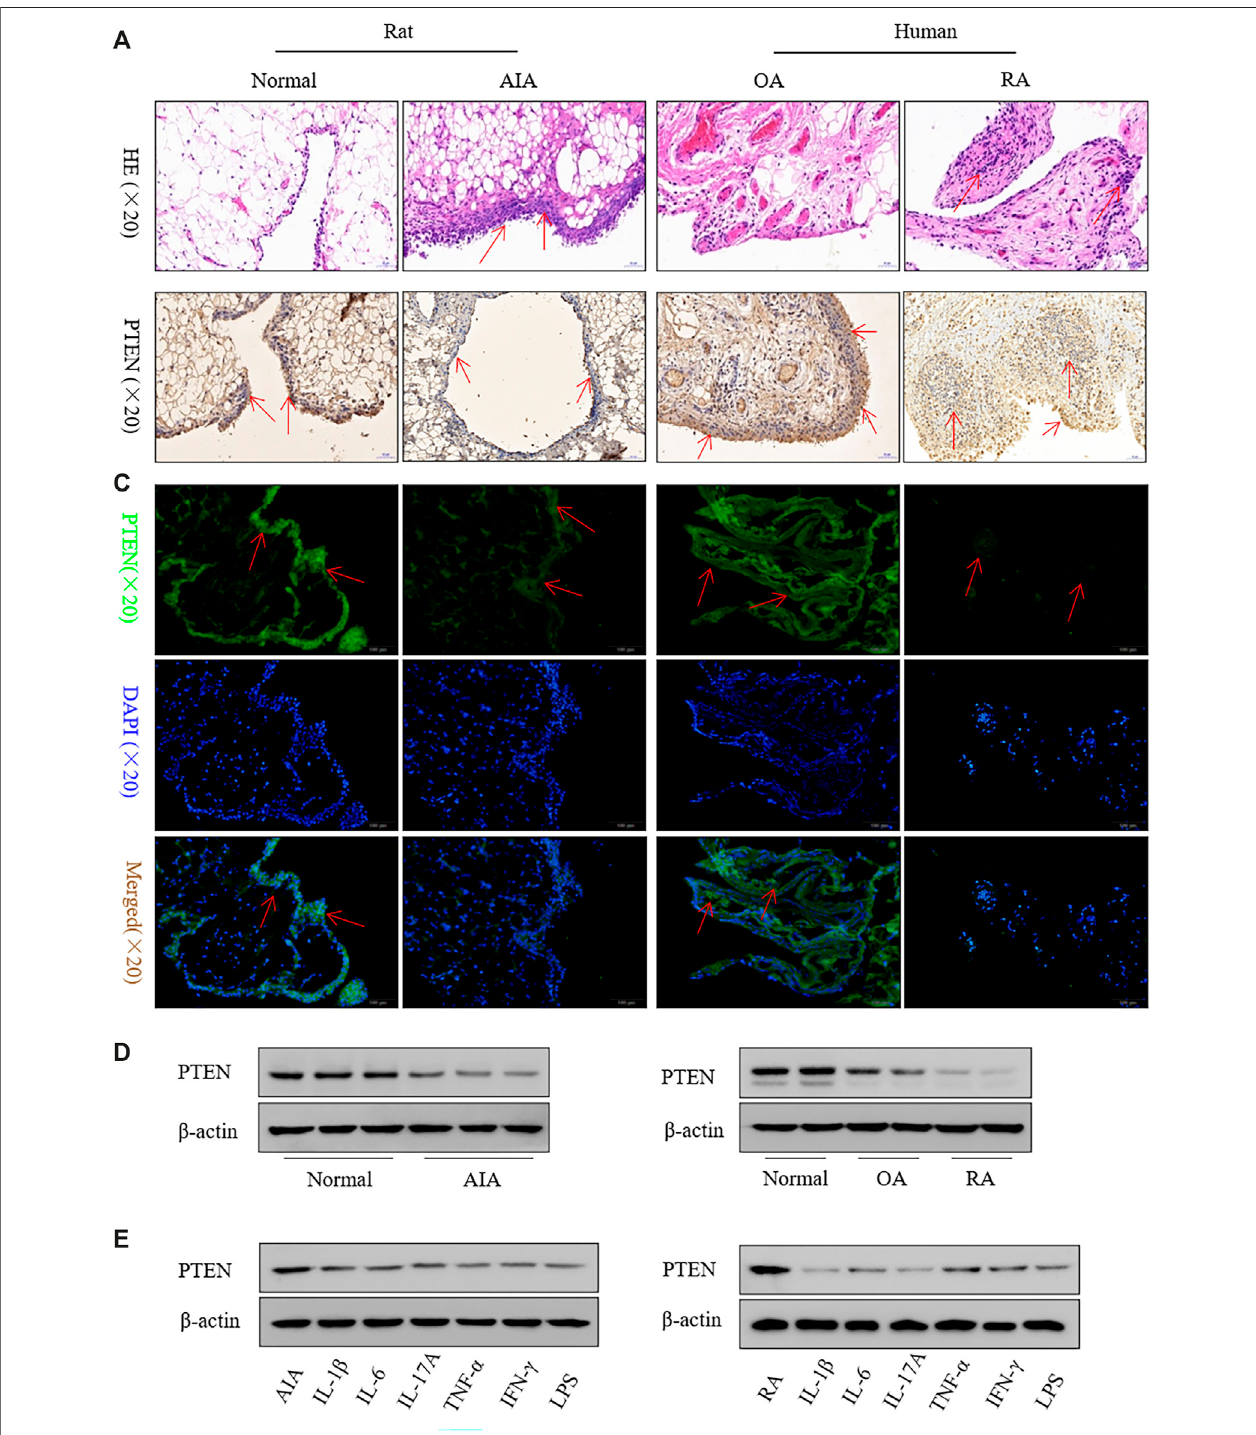
FIGURE 1 | PTEN expression is reduced in FLS from clinical RA specimens and a rat model of AIA. (A) Representative images of hematoxylin and eosin staining in synovium. (B, C) Representative images of PTEN immunoreactivity in synovium detected by immunohistochemistry (B) and immuno fl uorescence labeling (C) . (D) Western blot analysis of PTEN protein levels. (E) and after treatment with IL-1 β (2 ng/ml), IL-6 (5 ng/ml), IL-17A (10 ng/ml), TNF- α (10 ng/ml), IFN- γ (10 ng/ml), and lipopolysaccharide (LPS; 1 μ g/ml). Values represent mean ± SD of three different FLS samples.